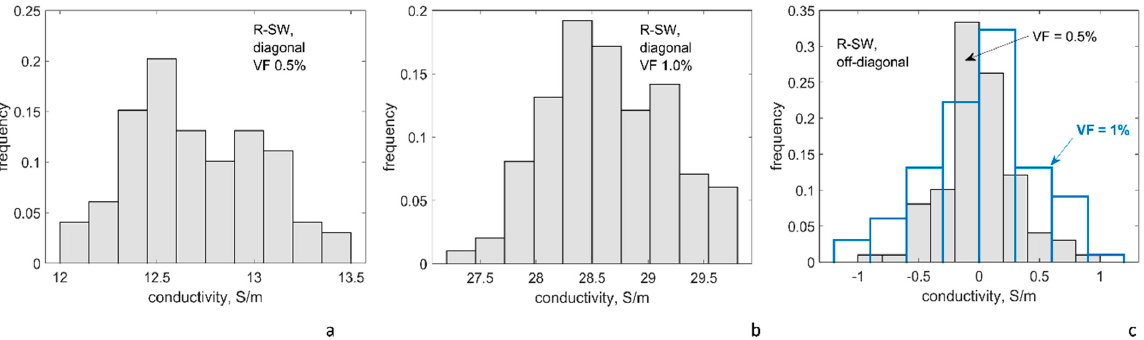
Figure 5. Conductivity tensor components for R-SW, histograms of the distributions: diagonal VF = 0.5% ( a ); VF = 1% ( b ); and off-diagonal VF = 0.5% and 1% components ( c ) ;the reference point of the